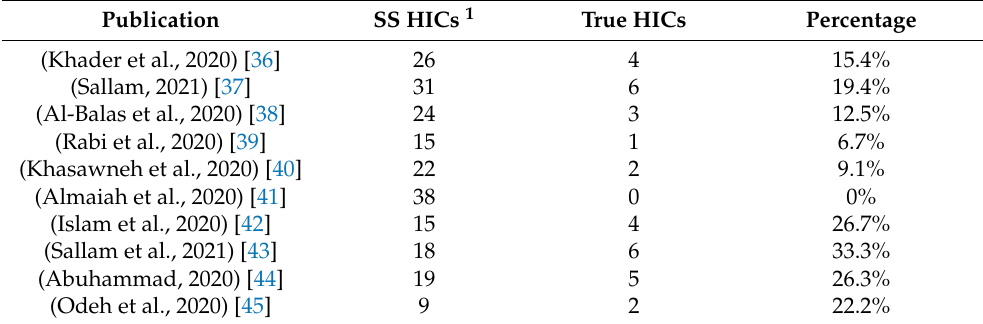
Table 3. Comparing the total number of HICs originally detected by semantic scholar and the resulting values after manual